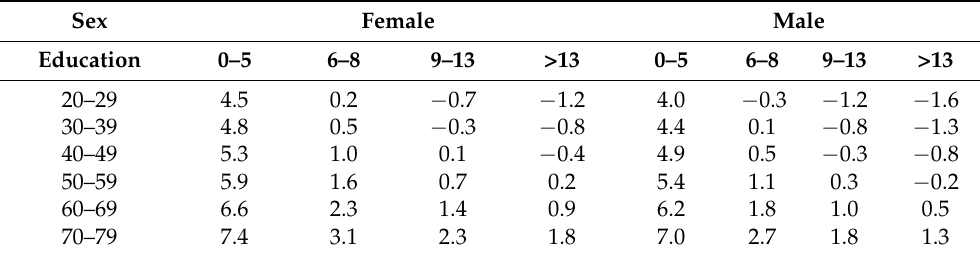
Table 5. Correction grid for accuracy on